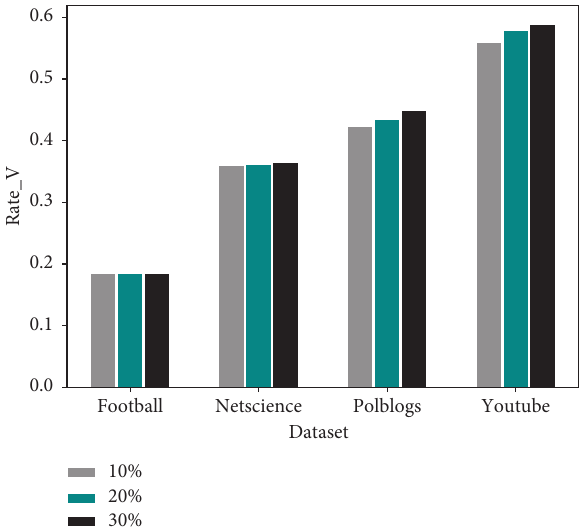
Figure 6: Different dataset points set compression